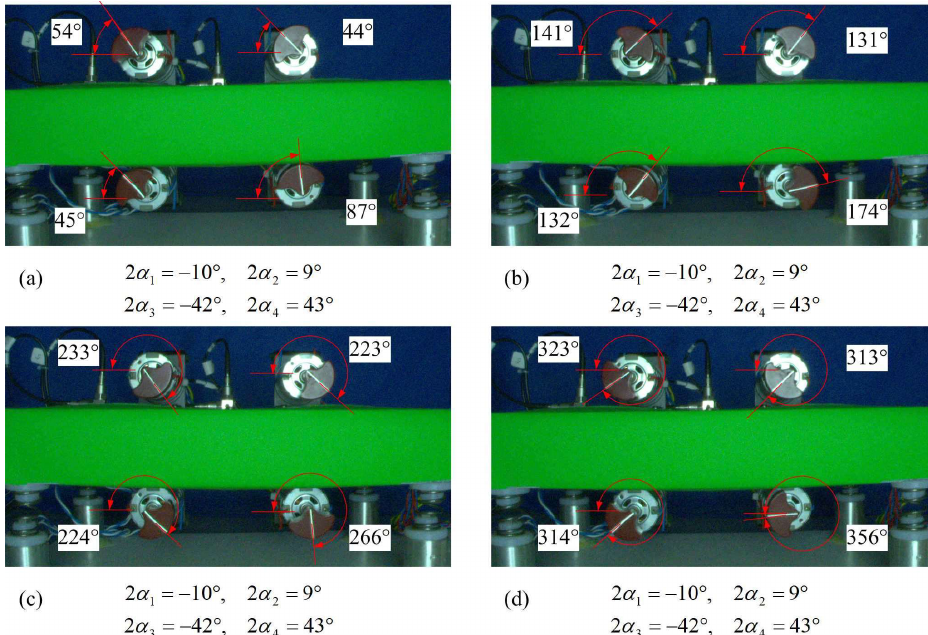
Figure 5. Phase differences of ERs change from  0 to  0 with disturbance: ( a ) Synchronous veloc- ities of four ERs; ( b ) Phase differences; ( c ) Acceleration amplitude in y direction at 20 s and 40 s; ( d ) Acceleration amplitude in x direction at 20 s and 40 s.